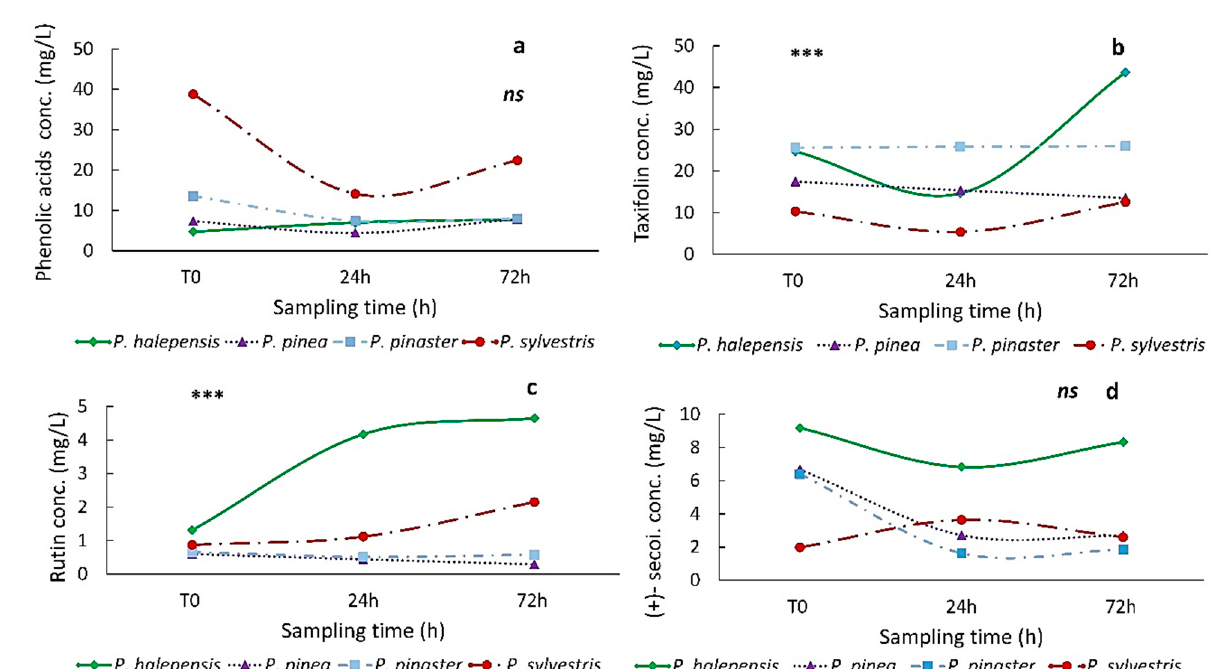
Figure 6. Plot of means of the two-way interaction (species × sampling time, ANOVA test) for phenolic acids ( a ), taxifolin ( b ), rutin ( c ), and (+)-secoisolariciresinol ( d ) in pinewood nematode-inoculated trees. Significant differences are indicated by an asterisk (*** p < 0.01 and ns —without significant difference).